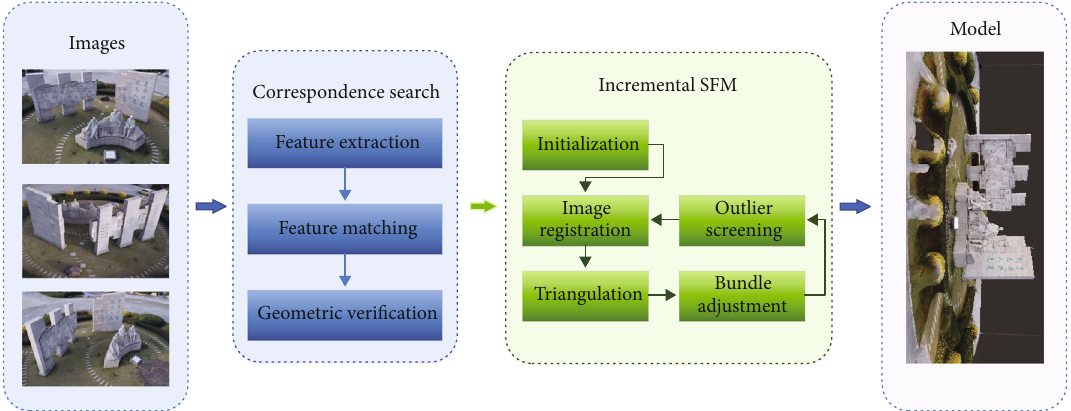
Figure 6: Incremental SFM algorithm reconstruction process.